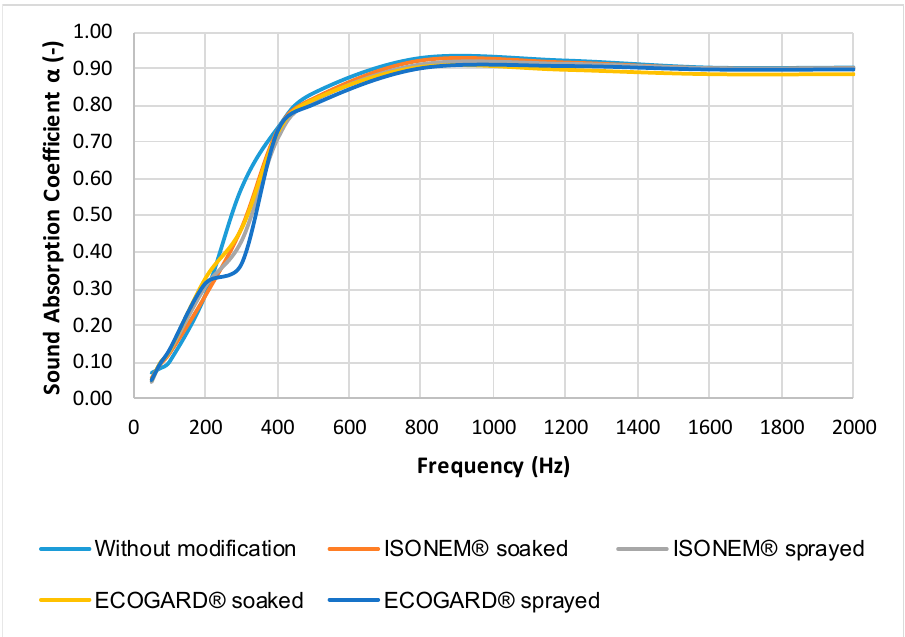
Figure 6. Frequency dependence of sound absorption coefficient α (-) of Senizol AT XX2 TL60 before and after application of ECOGARD ® B45 and ISONEM ® ANTI-FIRE SOLUTION.